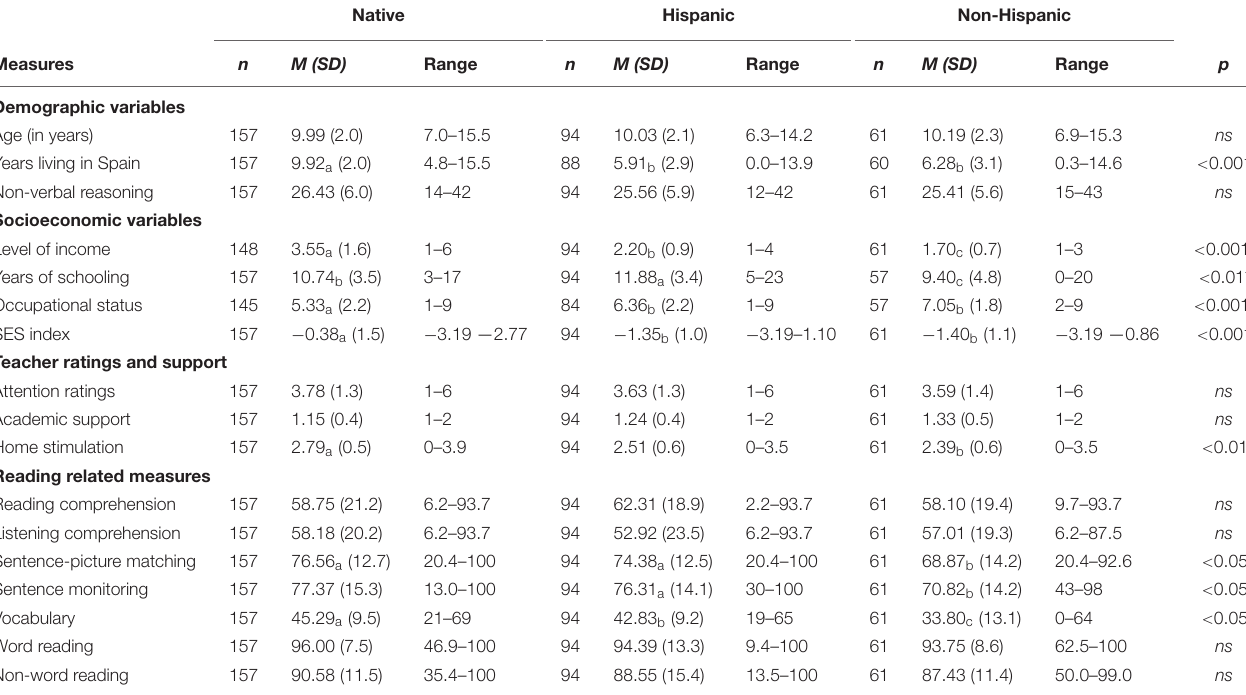
TABLE 1 | Means, standard deviations and range for all descriptive measures for native, Hispanic, and non-Hispanic children.